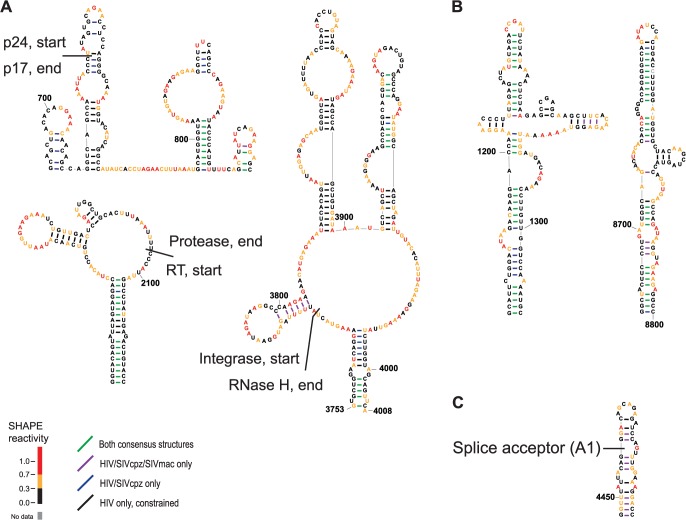
Novel conserved, likely functional, elements in the final HIV-1 structure model.(A) Structural elements located near protein-protein junctions. Protein domain junctions are labeled. (B) Conserved structural elements with the potential to form long (>20 bp) helical stacks. (C) Conserved structure at the A1 splice site, described in Pollom et al., recapitulated in this work [11].